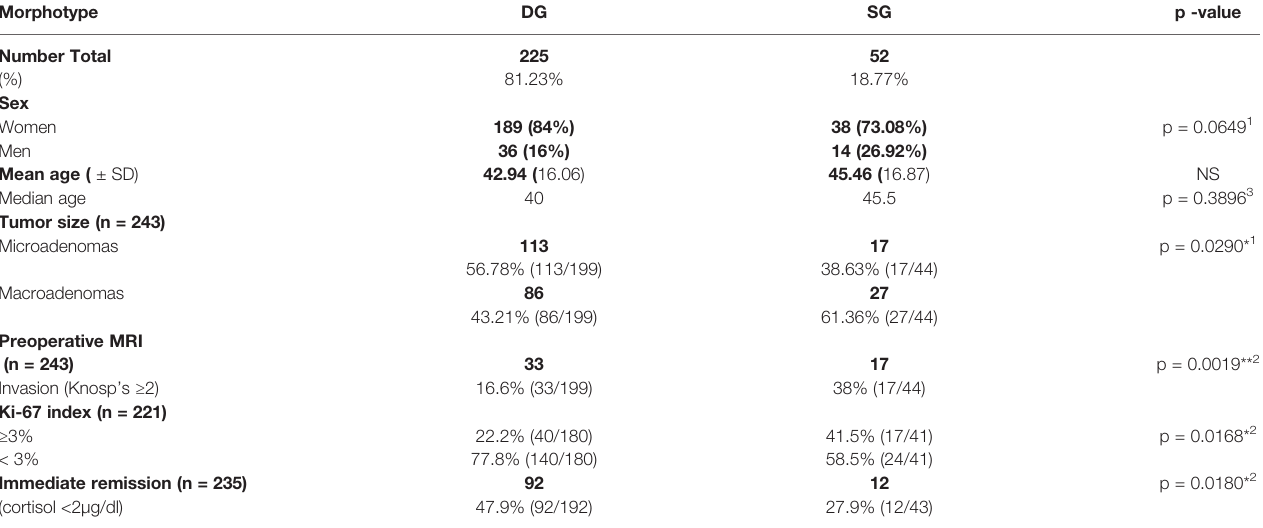
TABLE 1 | Clinical and tumoral differences between DG and SG corticotroph tumors in 277 patients with Cushing ’ s disease. Morphotype